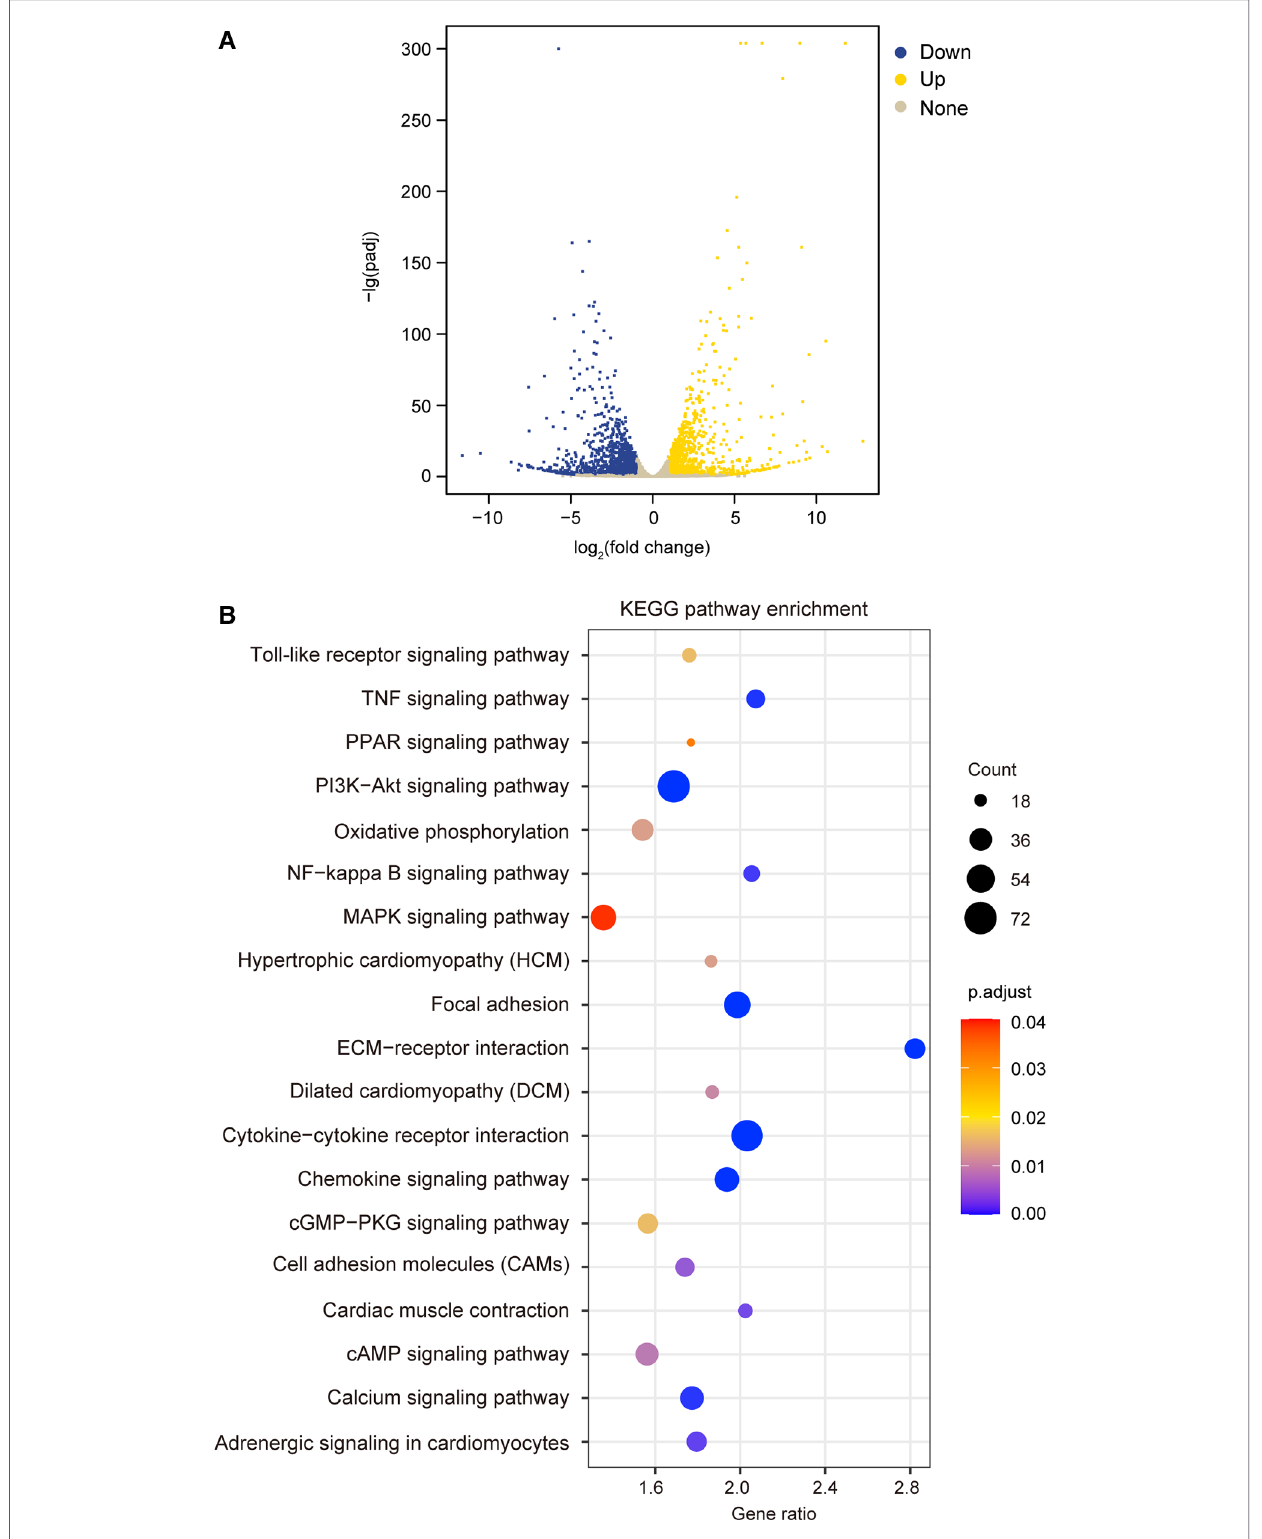
FIGURE 1 Recombinant TIMP3 (rTIMP3) modulated differential gene expression and potential pathways involved. ( A ) Avolcano picture shows differentially expressed genes (DEGs) regulated by rTIMP3, including up-regulated (Up) and down-regulated DEGs (Down) with change fold ≥ 2 and p.adjust <0.05 and other genes without signi fi cance (None). ( B ) KEGG pathway enrichment fi gure shows some pathways that were signi fi cantly regulated by rTIMP3 through DEGs in